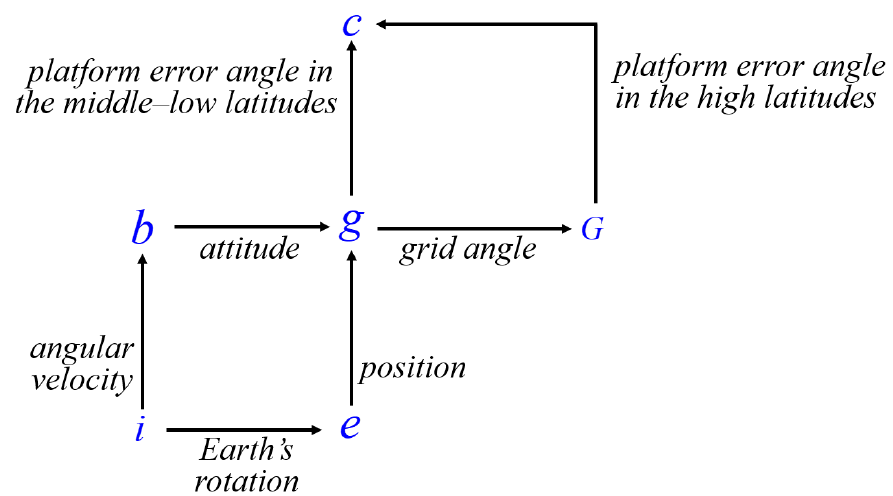
Figure 2. The relation between the